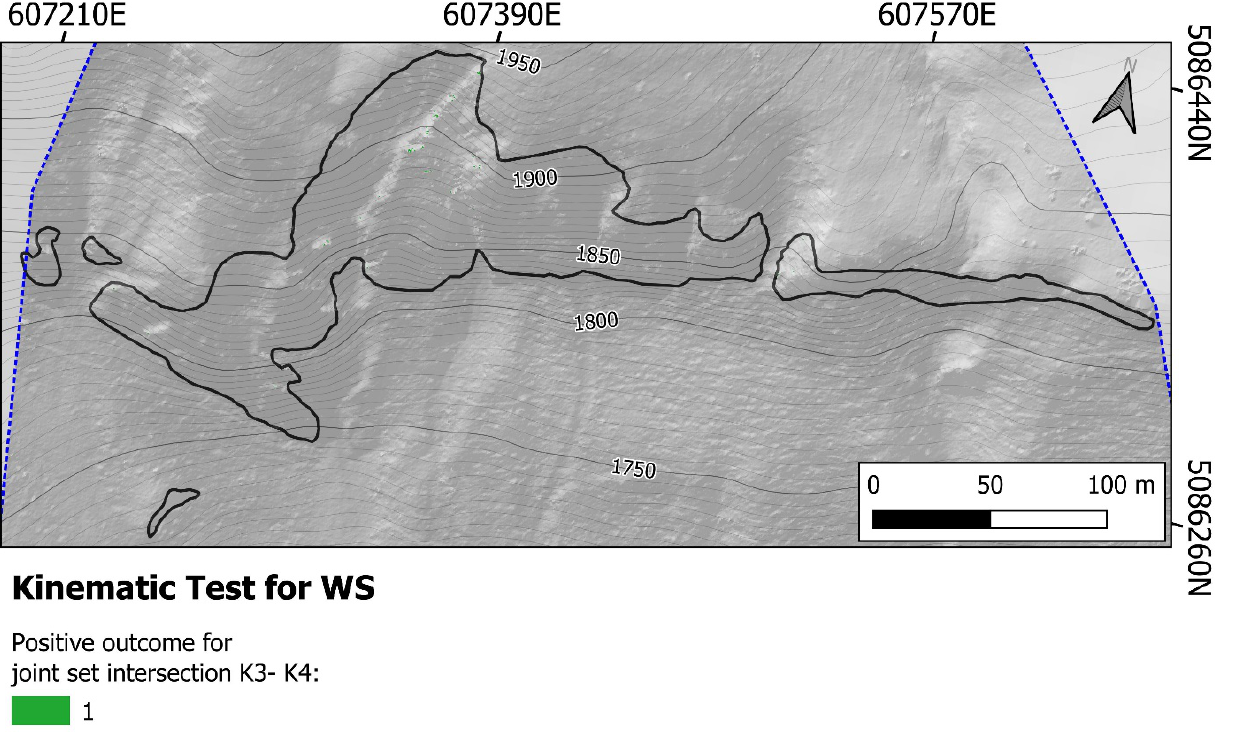
Figure A10. Image of the partial output file showing the kinematic test for WS performed considering only the intersection between joint set K3 and K4.